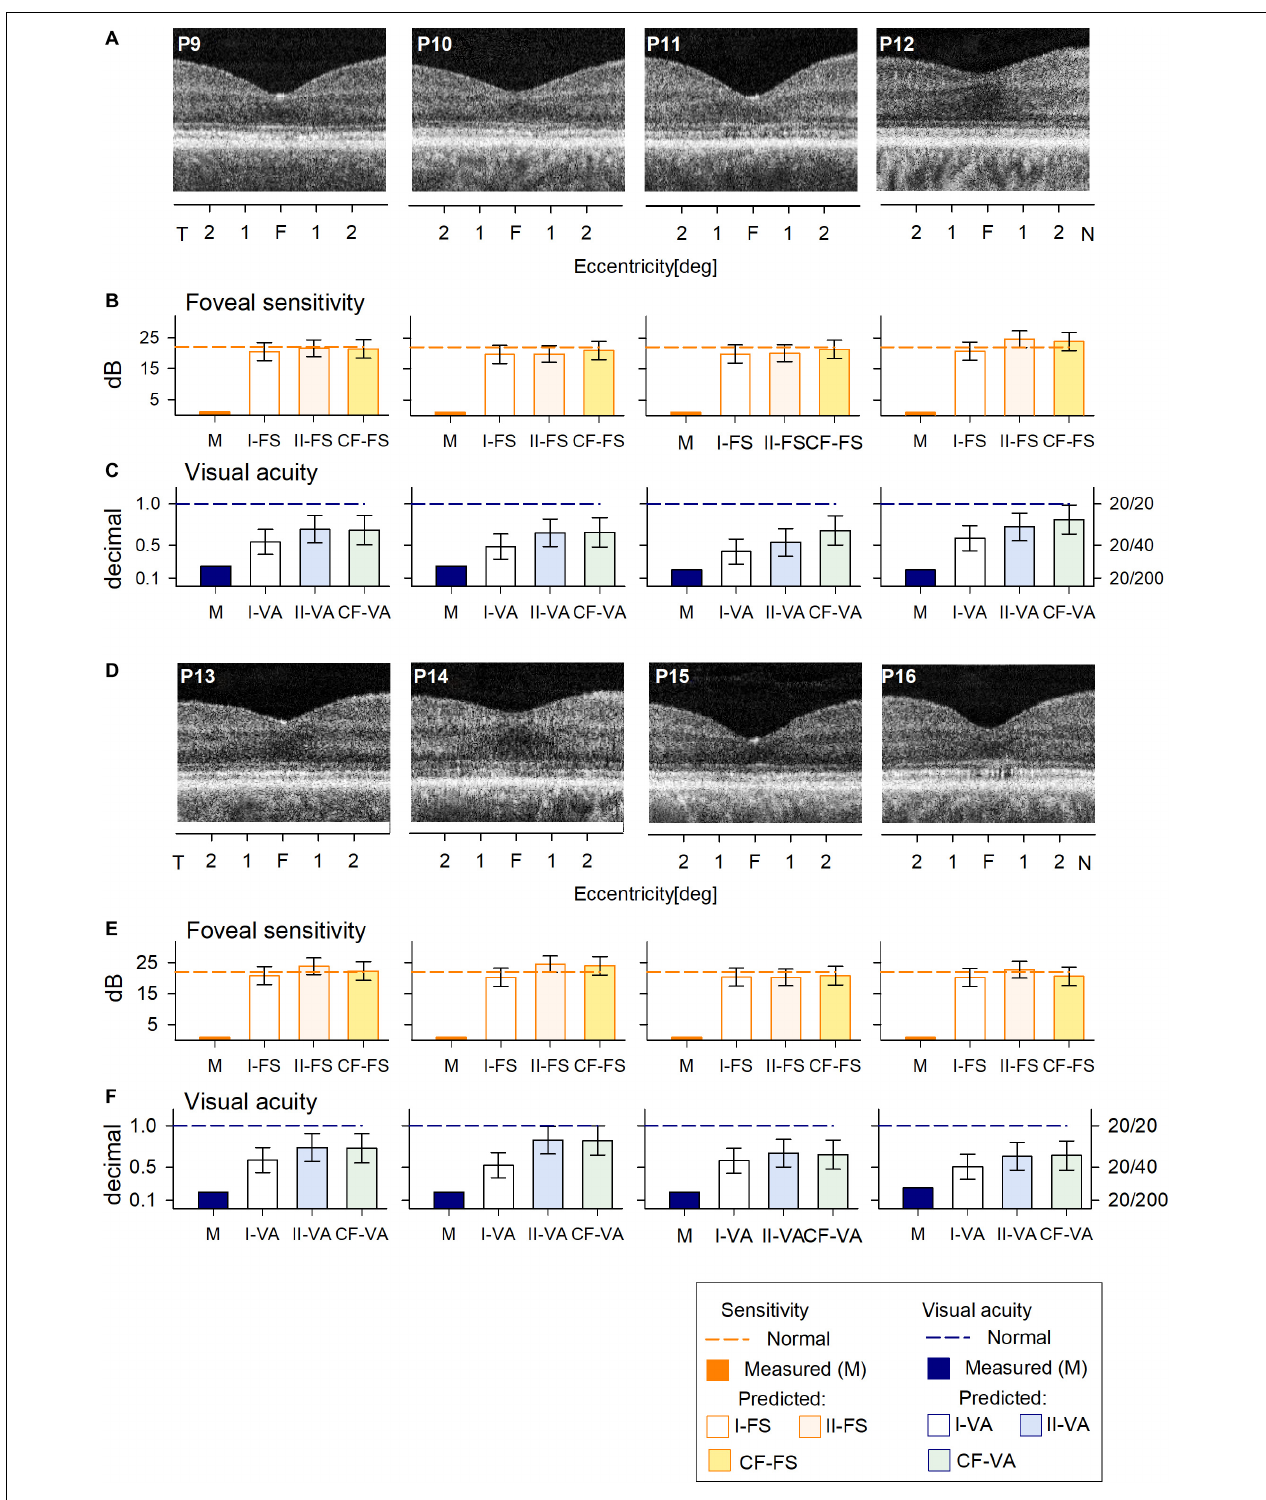
FIGURE 4 | Prediction of FS and VA of BCM patients with the C203R mutation. (A) Foveal region OCT scans from four BCM patients (ages 13–35 years). (B) Non-detectable sensitivity at foveal location (orange bar) and predicted results by Model I-FS (white bar), Model II-FS (light orange bar), and CF-FS (yellow bar) as in Figures 1 , 3 . (C) Comparison of measured VA (dark blue bar) and predicted and predicted by Model I-VA (white bar), Model II-VA (light blue bar), and CF-FS (light green bar). (D–F) are the same as (A–C) but BCM patients are older (ages 35–52 years); dashed lines (in B , C , E , F ) represent lower boundary of normal range. Error bars represent RSME for corresponding